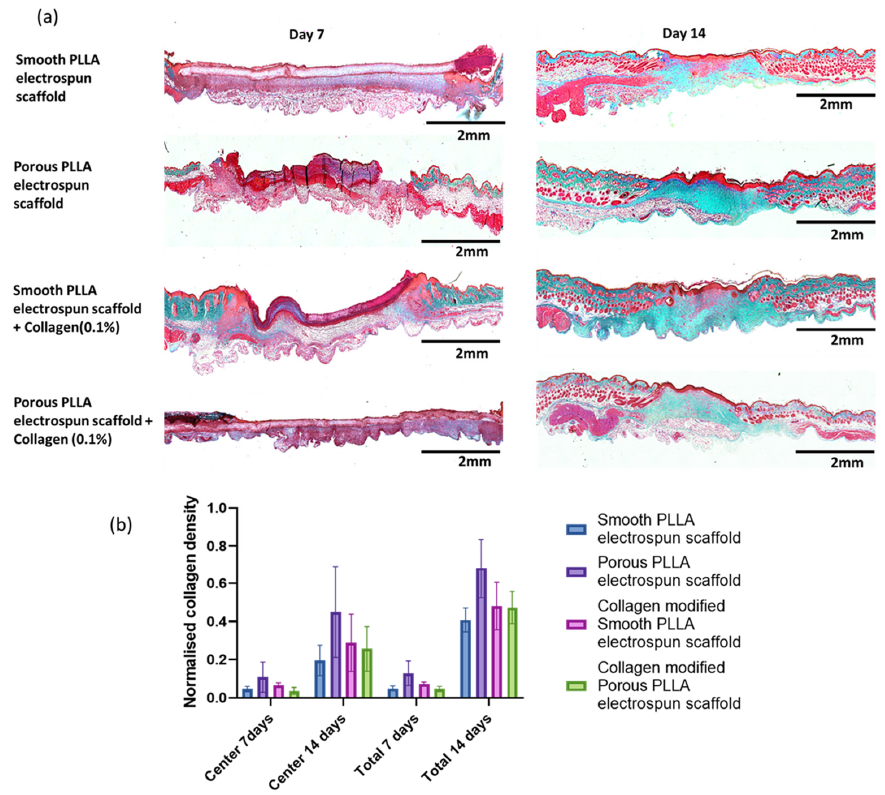
Figure 6. Collagen deposition analyzed by Masson’s trichrome staining. ( a ) Representative pictures of Masson’s trichrome staining showing collagen deposits (blue-stained) on day 7 and day 14, with various electrospun scaffolds as dressings. Scale bar = 2 mm. ( b ) Collagen deposition (normalized to unwounded skin) in the centre of the wound, and total wound on day 7 and day 14 on various scaffold treatments. All data are represented as mean ± SEM, n = 6 mice.